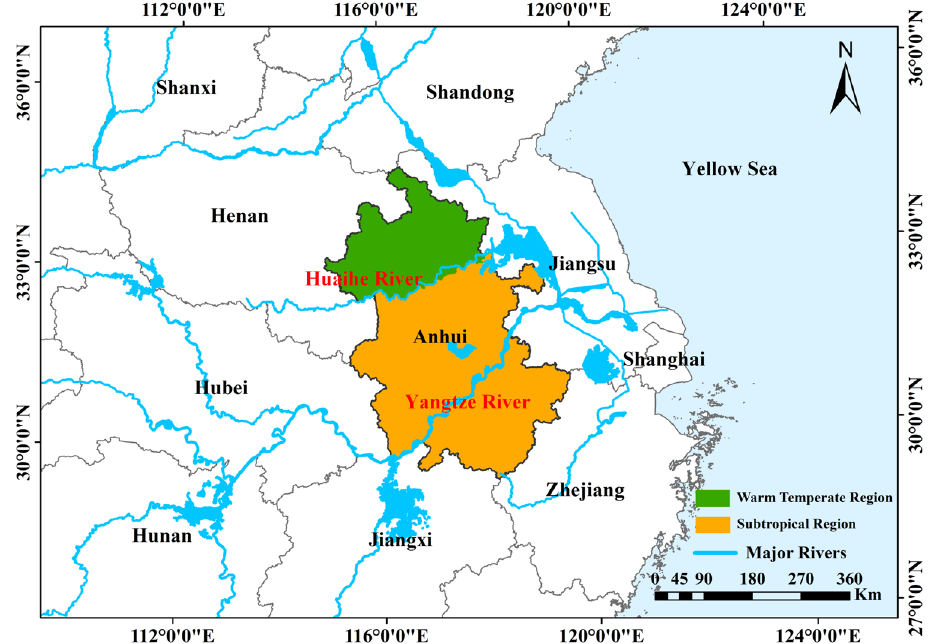
Figure 1. Map of climate types covering the study area.